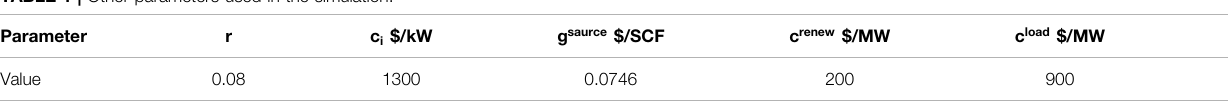
TABLE 1 | Other parameters used in the simulation.